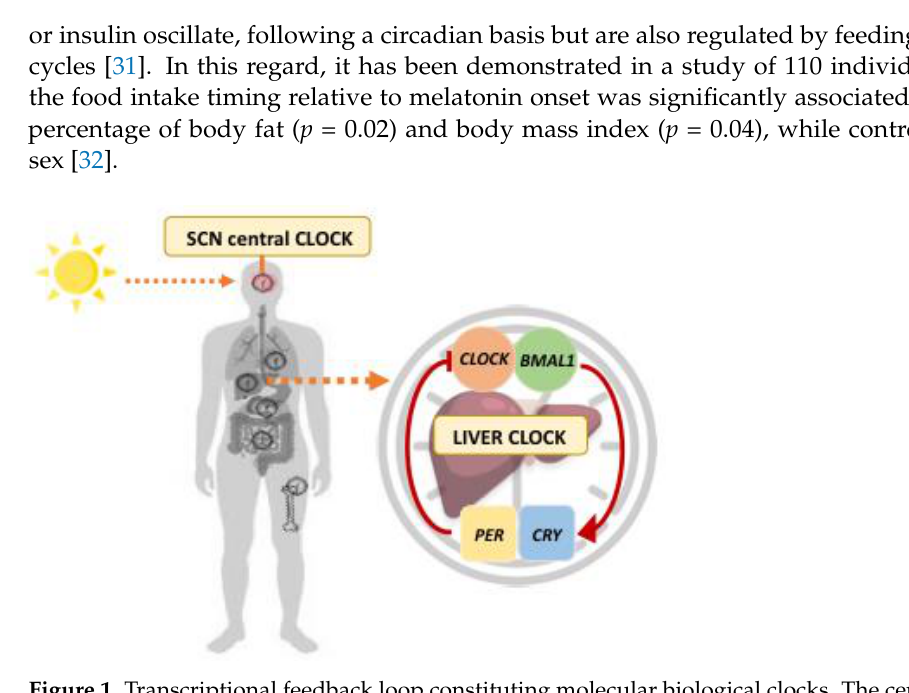
Figure 1. Transcriptional feedback loop constituting molecular biological clocks. The central clock of the SCN, driven by light, synchronizes the clocks of peripheral tissues, including the liver. At the heart of the molecular complex are the clock proteins CLOCK and BMAL1 that heterodimerize to induce transcription of the PER and CRY genes. This feedback loop takes approximately 24 h to complete and is the molecular basis of the mammalian biological clock. BMAL1 : Brain and Muscle Arnt-like protein-1; CLOCK : Circadian Locomotor Output Cycles Kaput; CRY : Cryptochrome; PER : Period; SCN: Suprachiasmatic Nucleus.